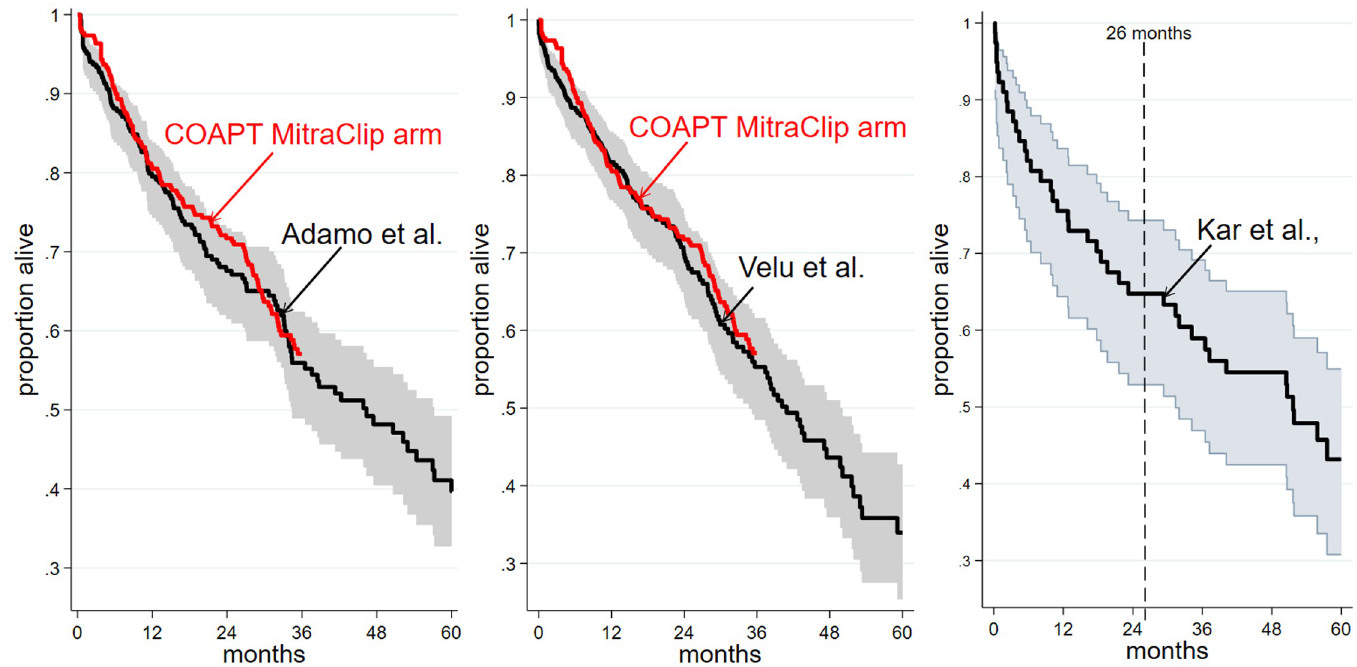
Fig 2. KM survival analysis of “real world” studies of PR with MitraClip compared to that for the PR + GDMT arm of COAPT. Red line represents the COAPT PR + GDMT KM, the black lines represent the reconstruted KM plots and 95% CI for “real world” studies.